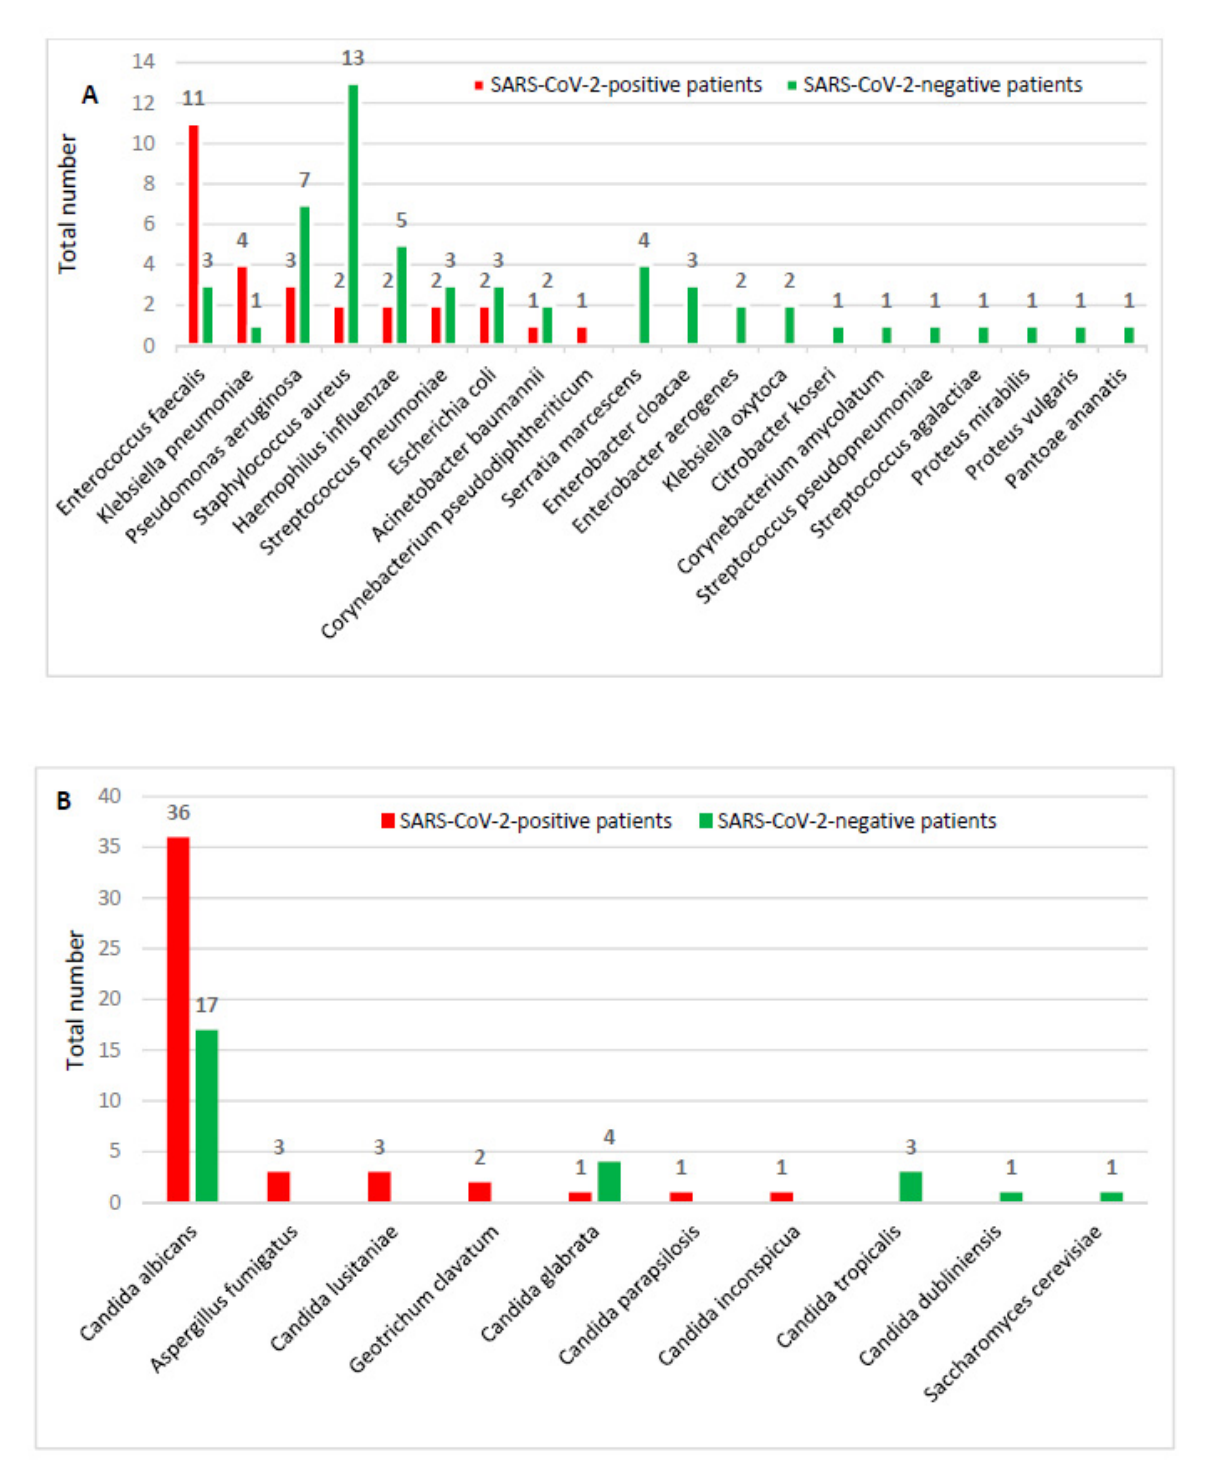
Figure 2. Distribution of bacteria ( A ) and fungi ( B ) among SARS-CoV-2-positive and -negative patients. Table 1. Infectious agents detected in the overall 301 lower respiratory tract samples. The average number of agents involved in co-infection among the SARS-CoV-2- positive patients was significantly lower (0.8 agents for each patient) than that observed among SARS-CoV-2-negative patients (1.3 agents for each patient) ( p = 0.0093). In 22 out of the 37 SARS-CoV-2-positive dead patients (59.5%), a co-infection with bacteria (2 patients, 5.4%), fungi (16 patients, 43.2%) or both (4 patients, 10.8%) was found; in the remaining 15 patients (40.6%), no co-infection was